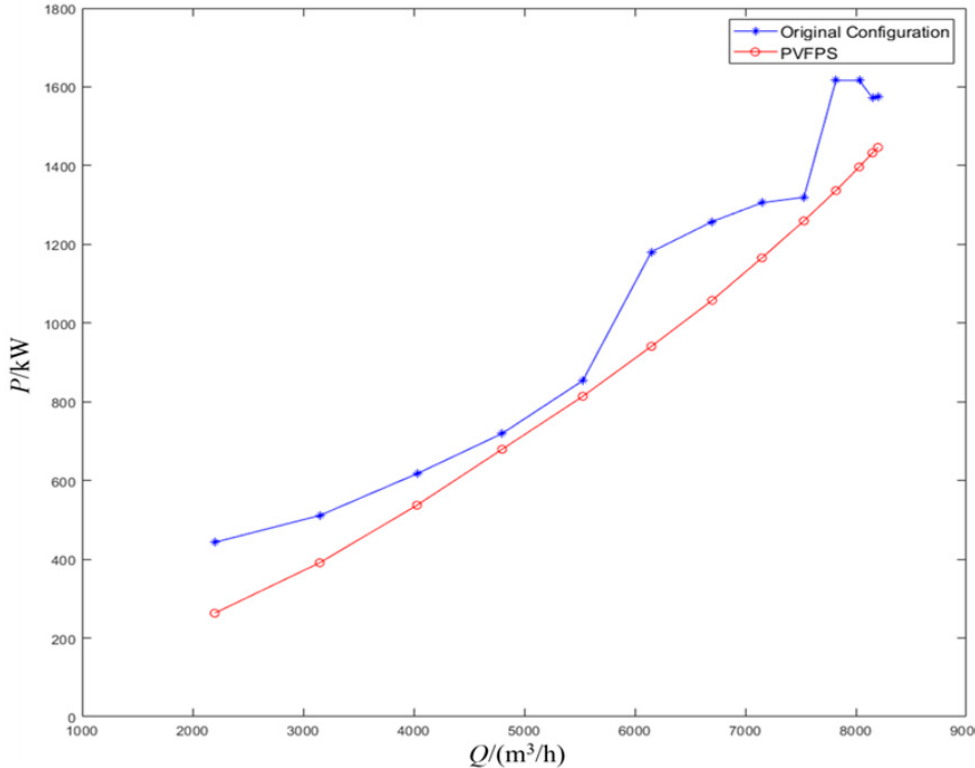
Figure 9. Shaft power of the original configuration and of the PVFPS.